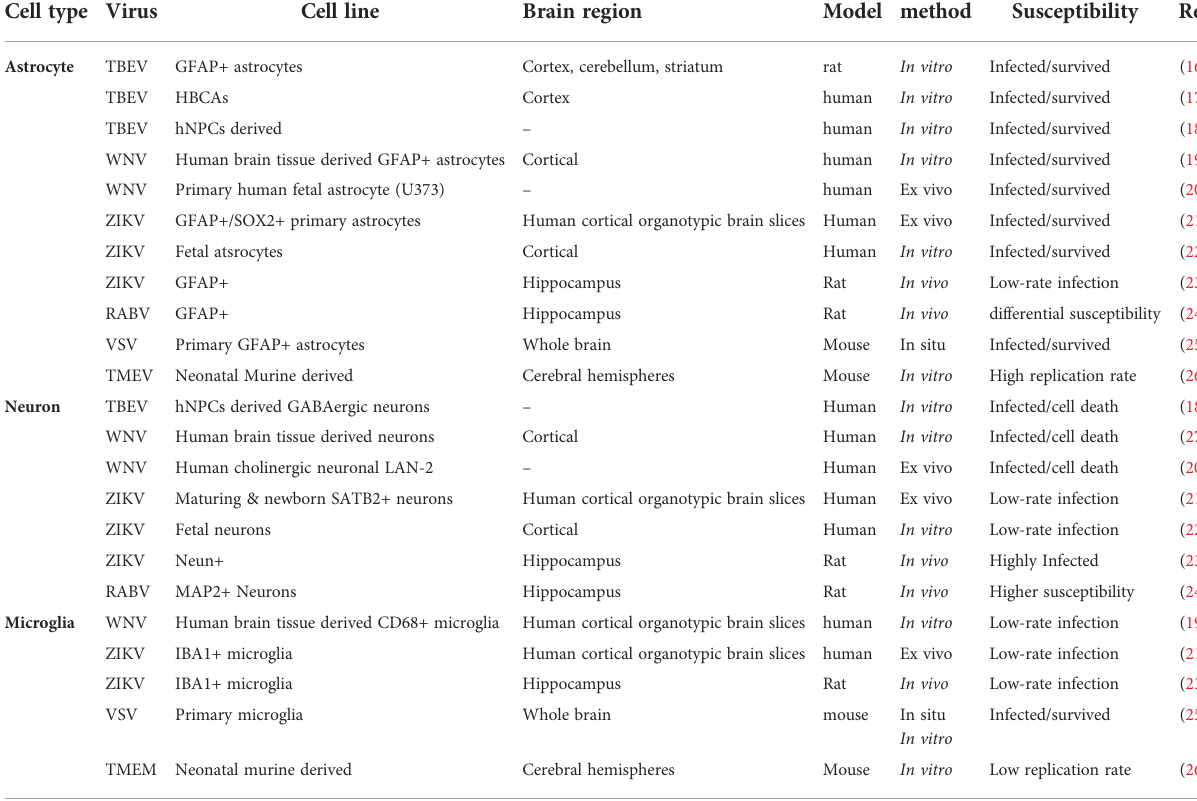
TABLE 1 CNS cell types susceptibility against several RNA & DNA viruses. Cell type Virus Cell line